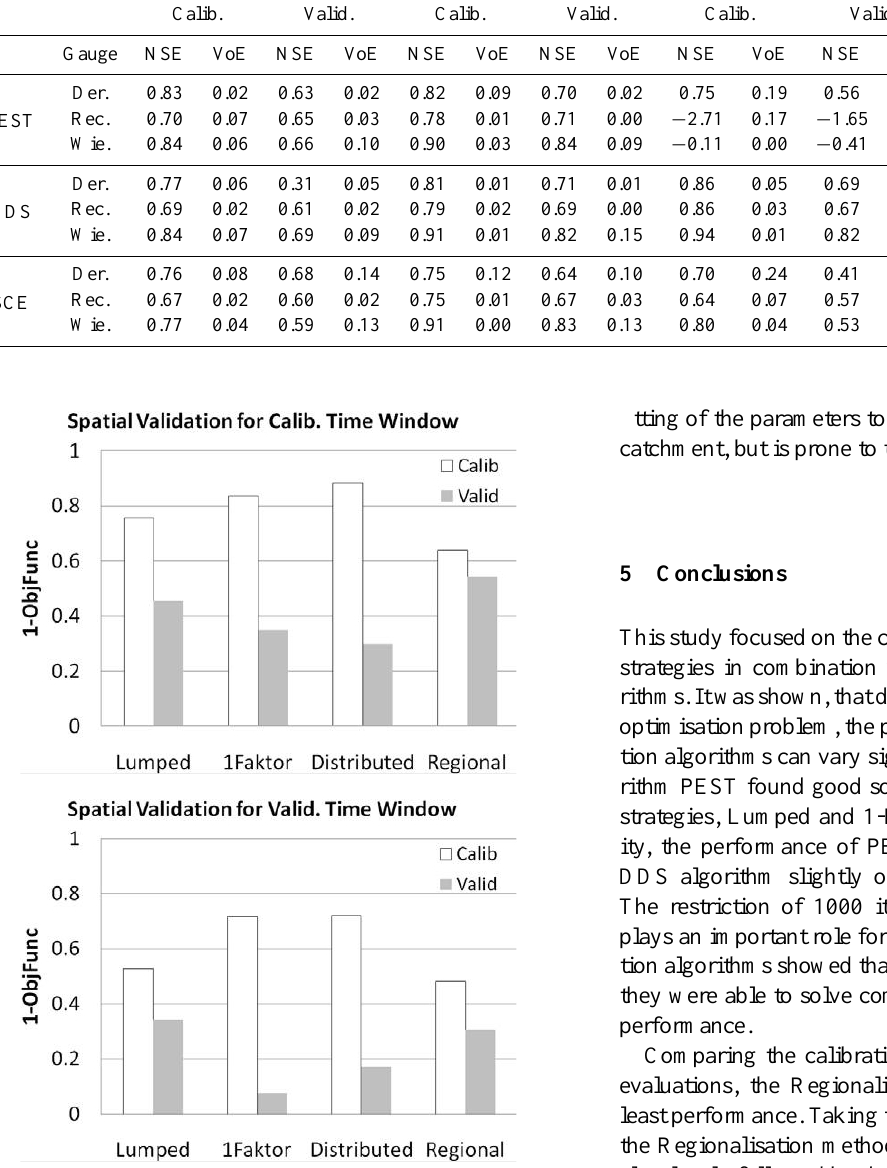
Fig. 7. Mean model performance calculated as 1.00 minus the av- erage over the objective function values (Eq. 9) of the respective catchments for the spatial evaluation in the calibration period (left figure) and in the validation period (right figure). The white bars show the mean performance for the three calibrated catchments (gauges: Derneburg, Reckershausen, Wieckenberg) and the grey bars represent the mean performance for the two validation catch- ments (gauges: Leineturm,